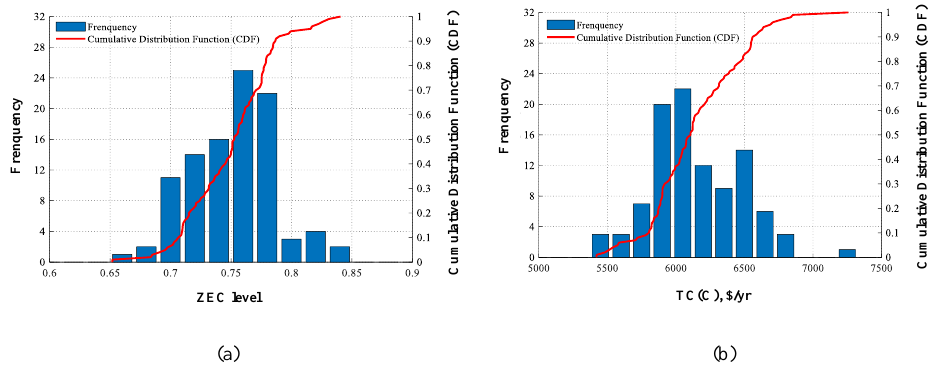
Fig. 8. (a) Distribution of ZEC level; (b) total cost of the community TC